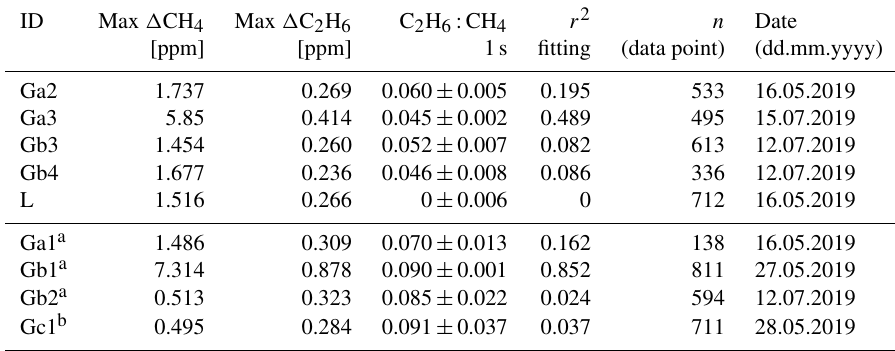
Table 6. Fieldwork. Ratio measured at three different gas compressor stations (Ga, Gb, Gc) and a landfill (L); (cid:49) CH 4 and (cid:49) C 2 H 6 are defined as the difference between background value (first percentile) and the observed value inside the peak.